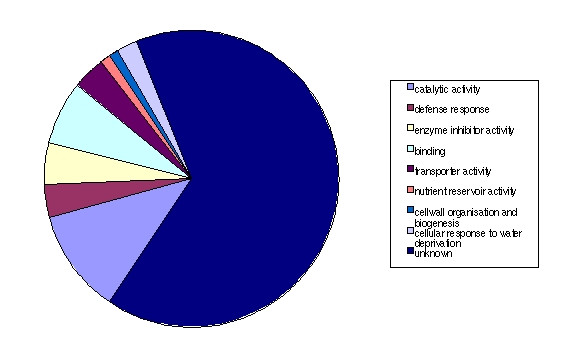
GO annotations for the gene families where positive selection  was detected using 3D windowing are shown. Compared with Figure 3, the  two methods detect different distributions of functions, with an  expanded number of positively selected proteins identified with 3D  windowing. The text describes these GO annotations normalized by the  total number of gene family branches.